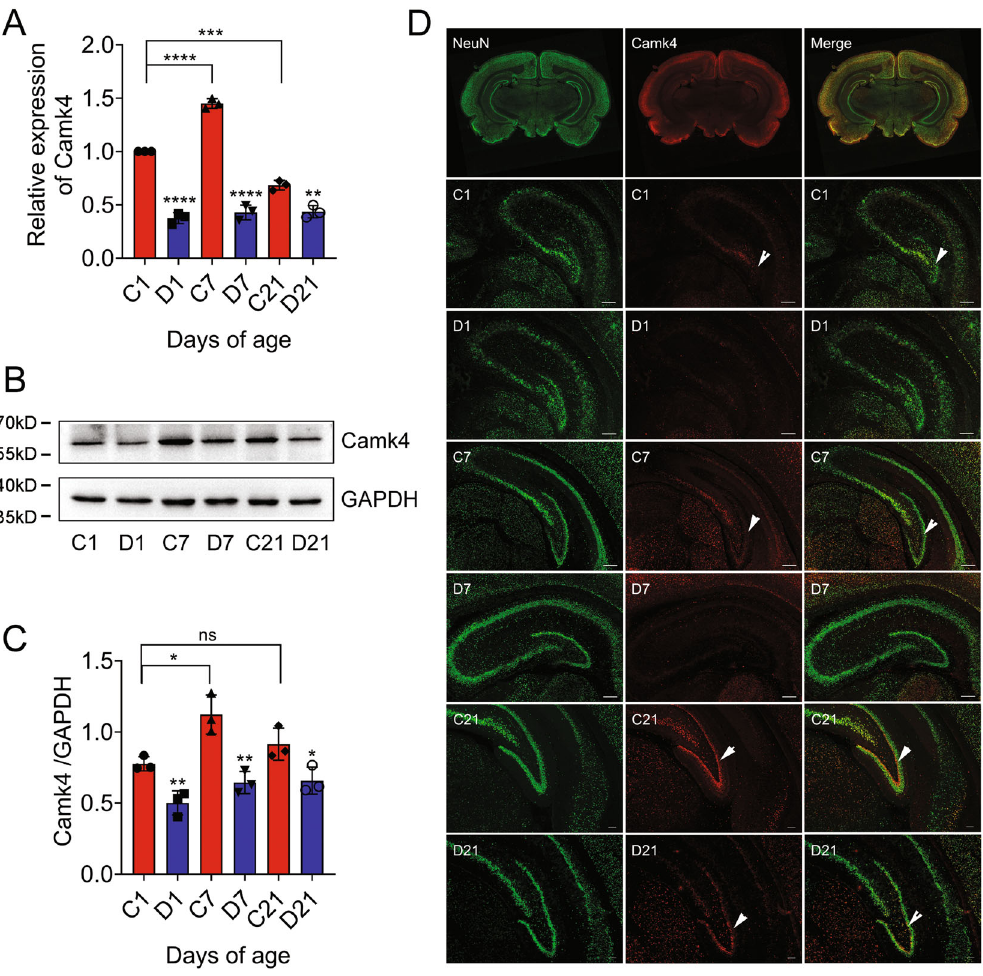
Fig. 5 Dynamic expression of CaMKIV in the hippocampus of rat pups following CH. A RT-PCR analysis of CaMKIV transcription in the hippocampus of P1, P7, and P21 pups following CH. B Western blot analysis of CaMKIV. C Statistical analysis of B . Experiments were performed in triplicates. Error bars represent the standard deviation ( P < 0.05). D CaMKIV immunostaining of the cross section from hippocampus of P1, P7, and P21 pups following CH. C1/7/21 indicates control, and D1/7/21 indicates CH. Arrowheads indicate positive signals in the dentate gyrus. Scale bars, 200 μ